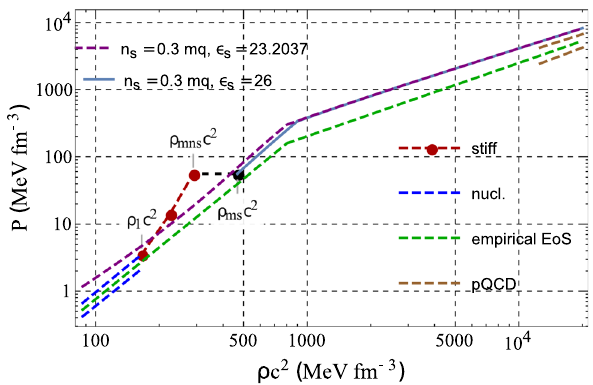
Fig. 3 EoS of multiquark interpolating between nuclear matter and extreme density region for (cid:2) s = 23 . 2037 , 26 GeV/fm 3 , notice the den- sity jump at the phase